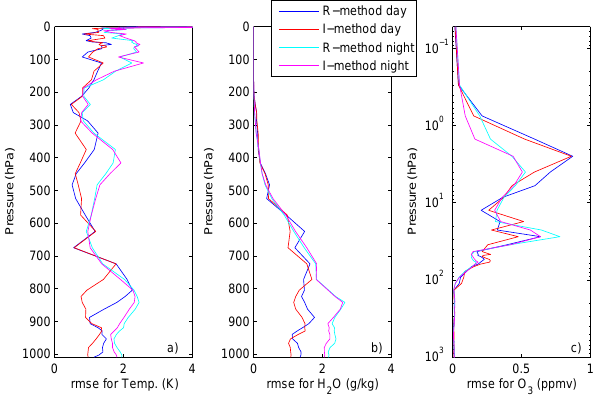
= 0 . 0701 cm). The figure t